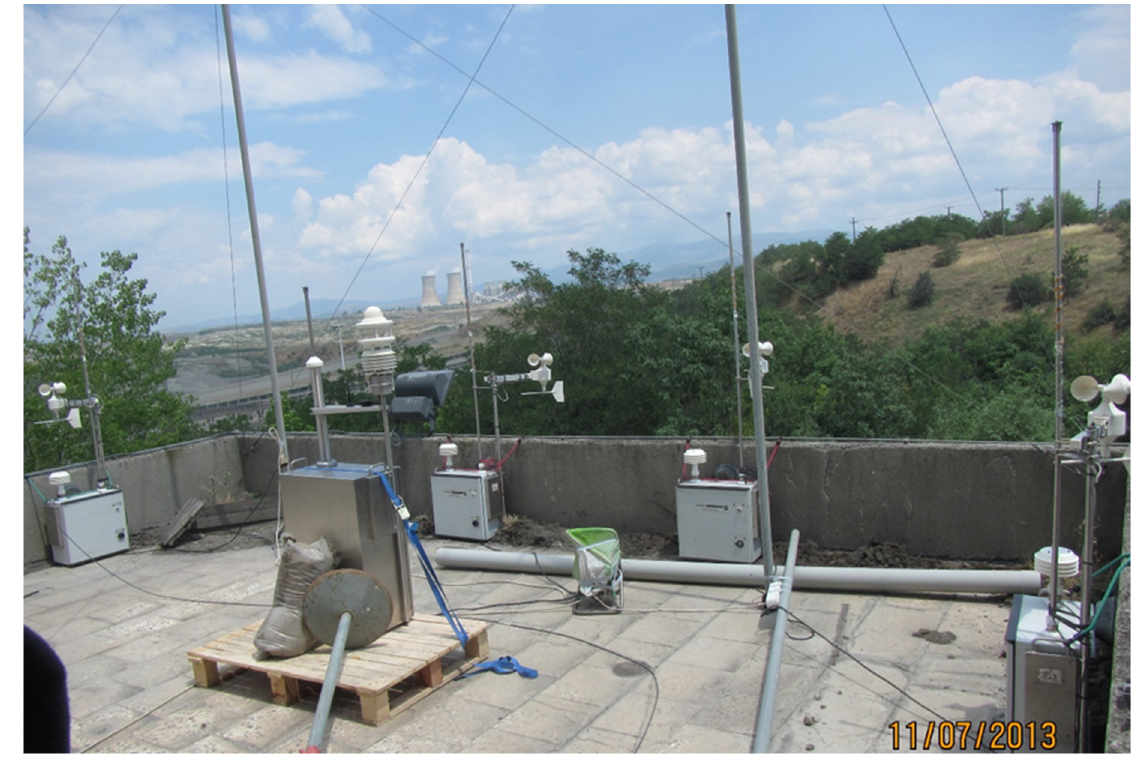
Mater. Proc. 2021 , 5 , x 4 of 4 Figure 1. The five PMx monitors (Grimm) and meteorological sensors of used for the measurement campaign located on the roof of Amyntaio mine control tower. Intercomparison of equipment performed at the start of each measurement period.